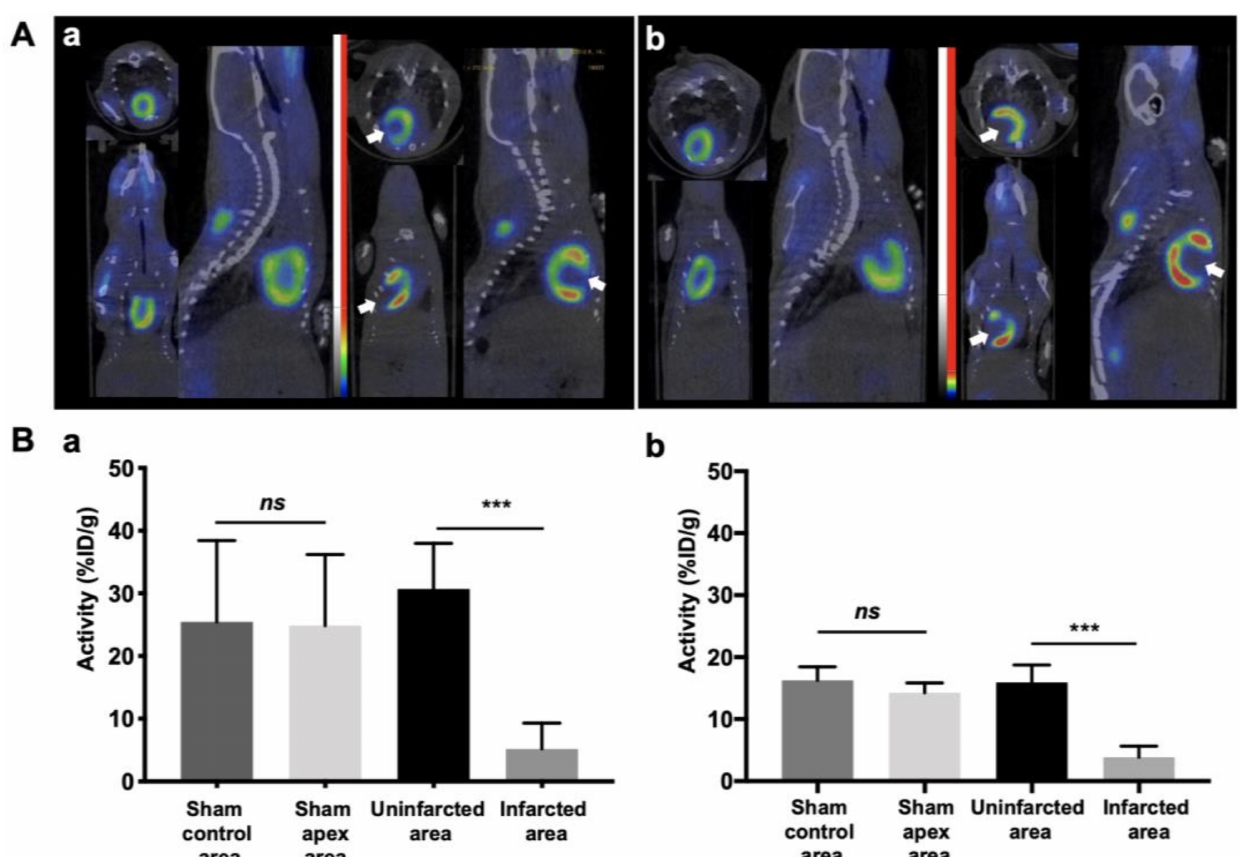
Figure 2. Myocardial infarction resulted in myocardial viability defect evaluated by 18 F-FDG microPET imaging. ( A ) 18 F- FDG microPET imaging showed a signal decrease in the infarcted myocardium identified by a white arrow at day 16 ( a ) and at day 30 ( b ) post-surgery. ( B ) Semi-quantitative analysis expressed as percentage of injected dose per gram of mouse (%ID/g mean ± SD) for day 16 ( a ) to day 30 ( b ) post-surgery showed a significant decreased in Apex area compared to control area (Mean apex = 5.19 ± 4.10%ID/g, Mean control = 30.7 ± 7.25%ID/g, n = 7; *** p = 0.0003 at day 16) and (Mean apex = 3.84 ± 1.81%ID/g, Mean control = 15.9 ± 2.81%ID/g, n = 7; *** p = 0.0003 at day 30). In contrast, uptake was homogeneous in sham hearts for both experiment time (Mean apex = 24.8 ± 11.3%ID/g, Mean control = 25.4 ± 12.9%ID/g, n = 4; ns : p = 0.443 at day 16) and (Mean apex , 14.3 ± 1.54%ID/g, Mean control 16.2 ± 2.20%ID/g, n = 4; ns : p = 0.885 at day